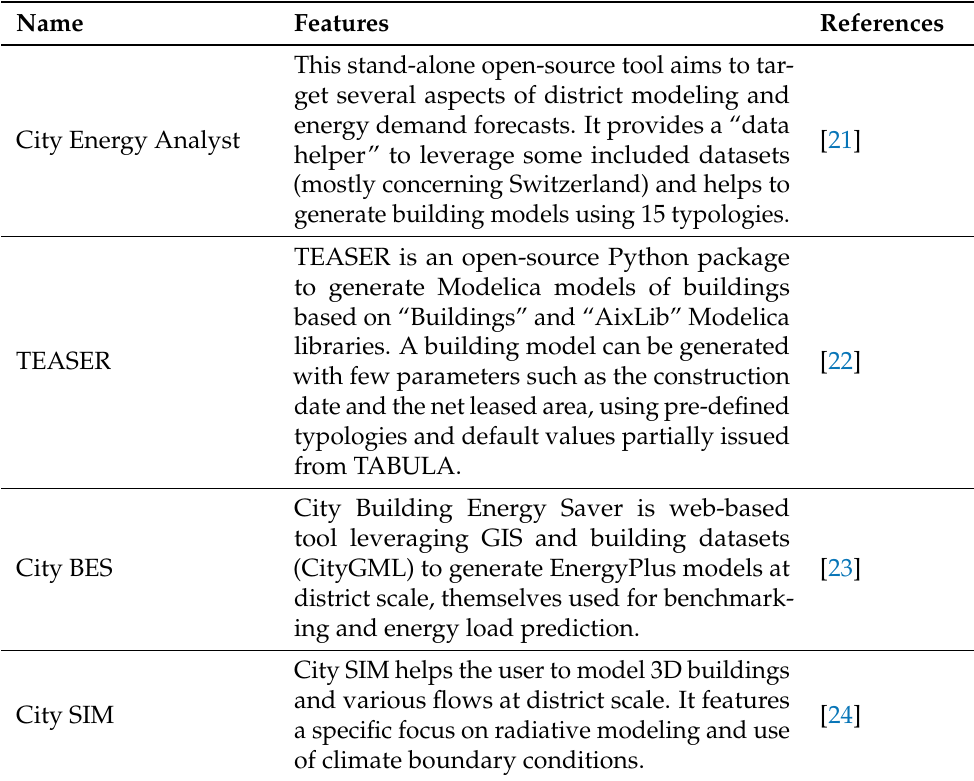
Figure 1. Main approaches in Urban Building Energy Modeling (UBEM). Top-down strategies are mostly used at a macroscopic scale (coarse variables at national/international scales), and try to use simple models such statistical regression to link energy consumption with macro-economic indicators at a national scale. However, their use is limited in time because based on historical data. They are less prone to provide detailed insights due to their macroscopic nature, but in conjunction with GIS data, a good spacial resolution can be reached as shown in [18]. Conversely, bottom-up approaches try to start from detailed models to describe the stock and compute energy consumption by aggregation. To do so, we can use physically based models (white-box), data-driven models (black-box) or anything in-between (mixed/hybrid models). Many bottom-up tools for Urban Buildings Energy Modeling (UBEM) rely on the concept of “building archetypes” or typologies to deal with data lacunarity and modeling complexity. Table 2 lists some of these tools with a specific focus on physical models. For extensive reviews of bottom-up UBEM tools, the interested reader can refer to [19,20]. Table 2. City and district buildings modelers